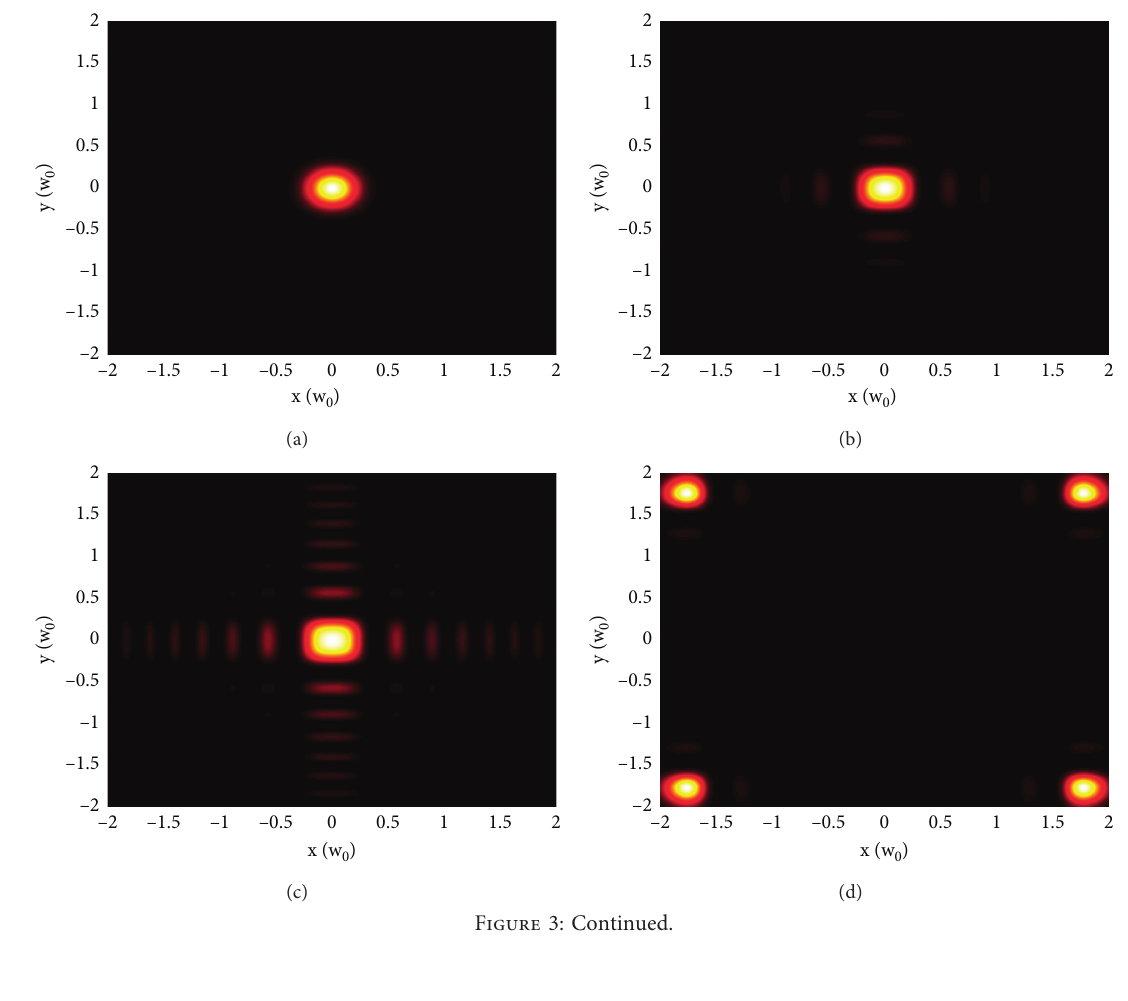
Figure 2: Incident PCAFABs changed with different σ ; other parameters are the same as those in Figure 1 except for a (b) σ ⟶∞ .